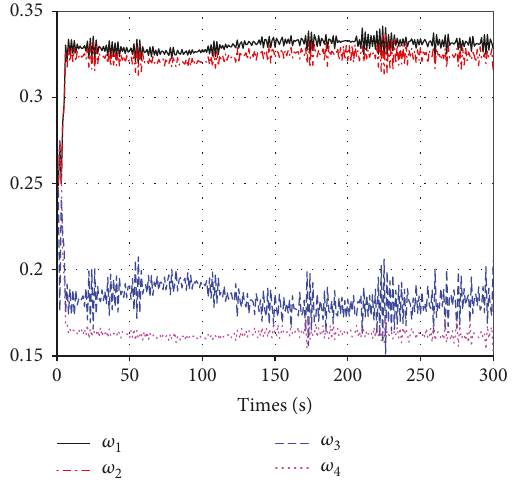
Figure 7: Information distribution coe ffi cients in one